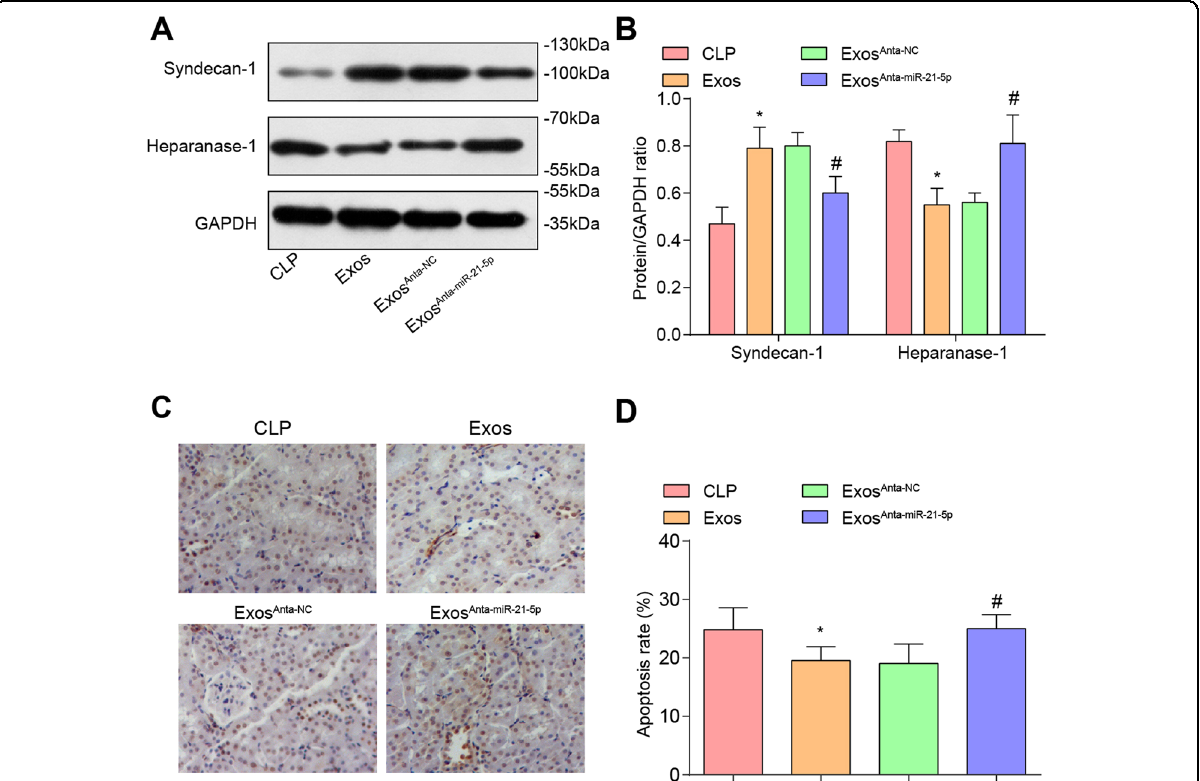
Fig. 6 EPCs-Exos raise syndecan-1 and reduce heparanase-1 levels, and reduce apoptosis in renal tissues of CLP rats. A Protein bands of syndecan-1 and heparanase-1 in renal tissues of CLP rats. B Comparison of syndecan-1 and heparanase-1 protein contents in renal tissues of CLP rats. C TUNEL staining was used to detect the apoptosis of rat renal cells (scale bar = 50 μ m). D Comparison of renal cell apoptosis rate in CLP rats. n = 10. * P < 0.05 vs. the CLP group. # P < 0.05 vs. the Exos Anta-NC group. Measurement data were depicted as mean ± standard